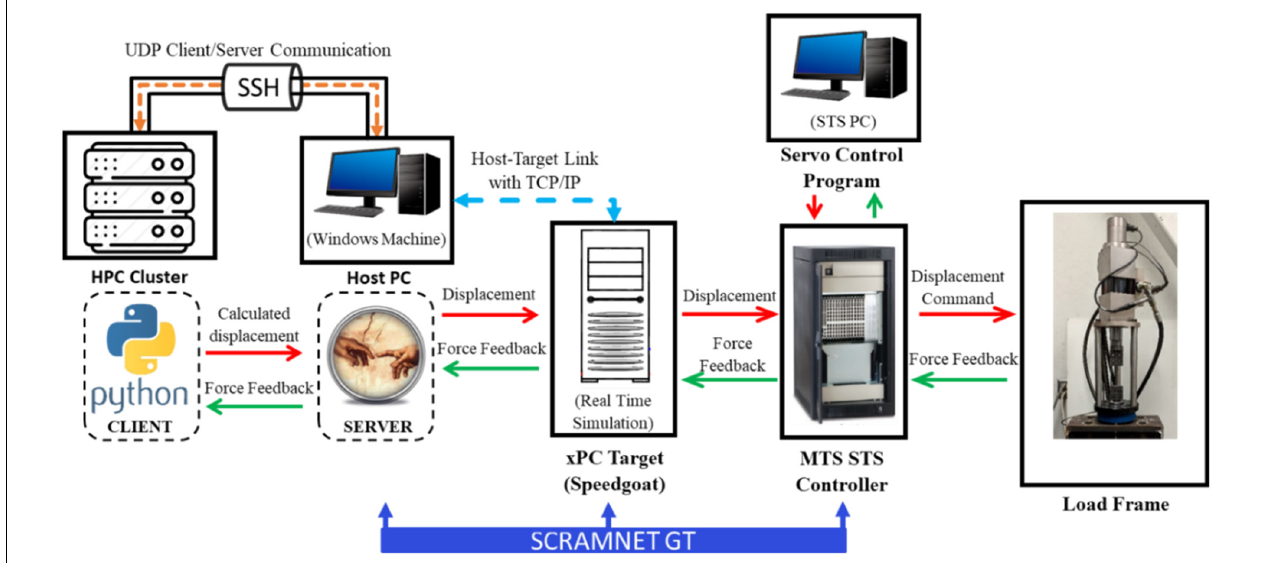
FIGURE 13 | HS/RTHS communication details for Python-based analytical substructure (metamodel) located at and called from high-performance